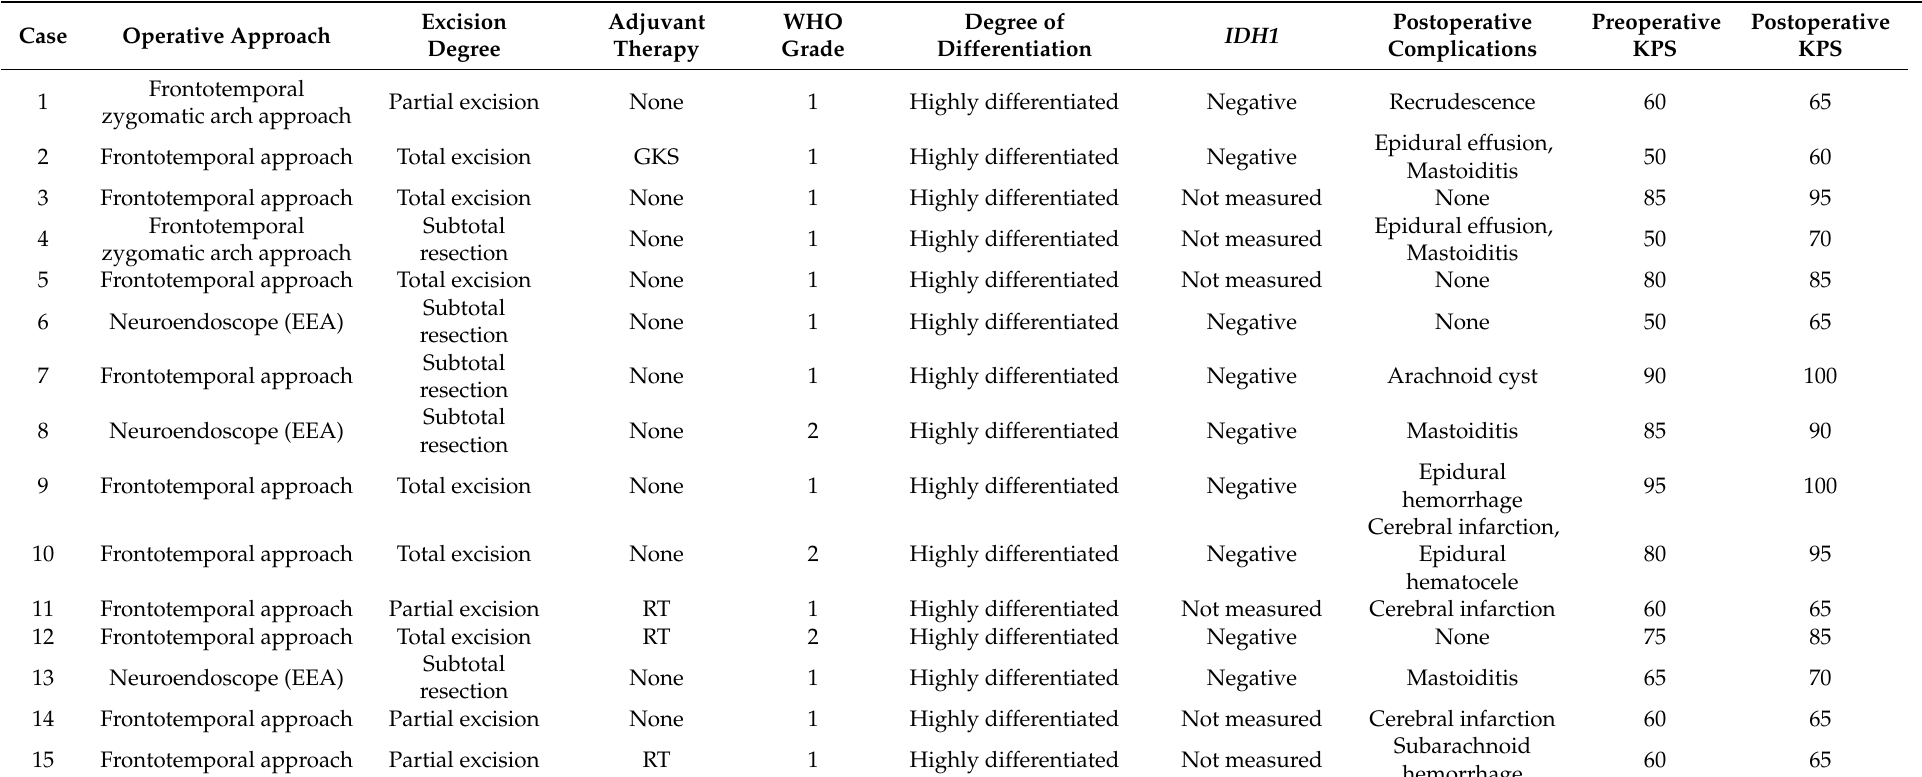
Table 2. Surgical information of 15 patients with parasellar